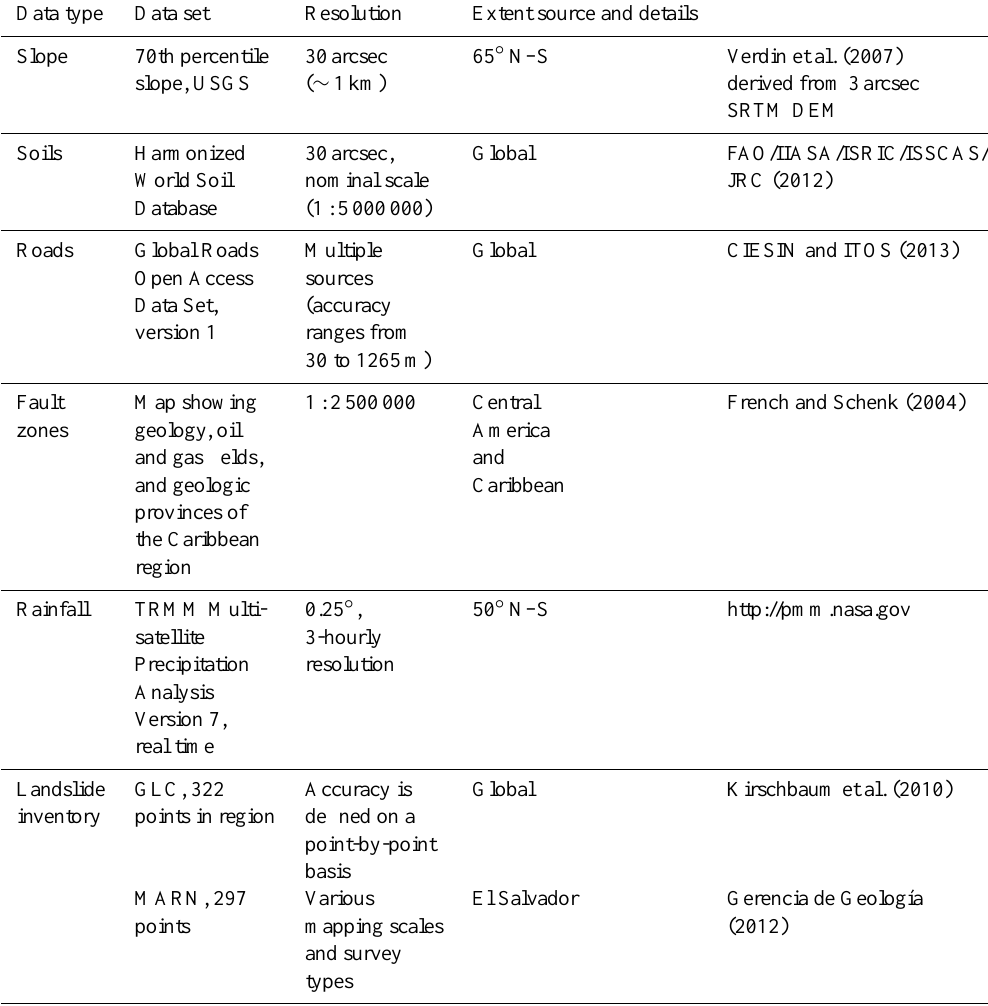
Table 1. Data sources used in the LHASA